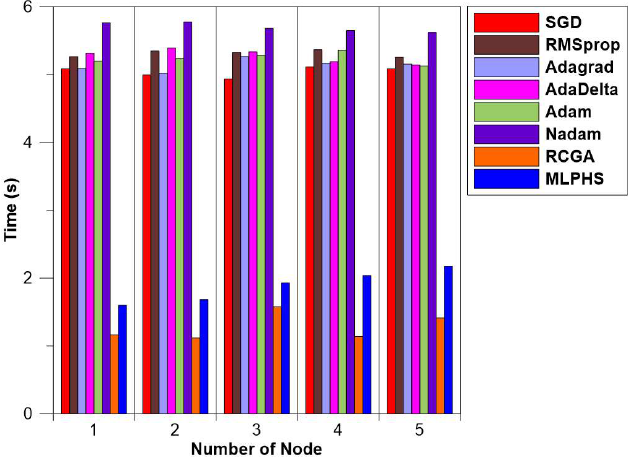
Figure 8. Comparison of average time required for each optimizer according to the number of nodes.